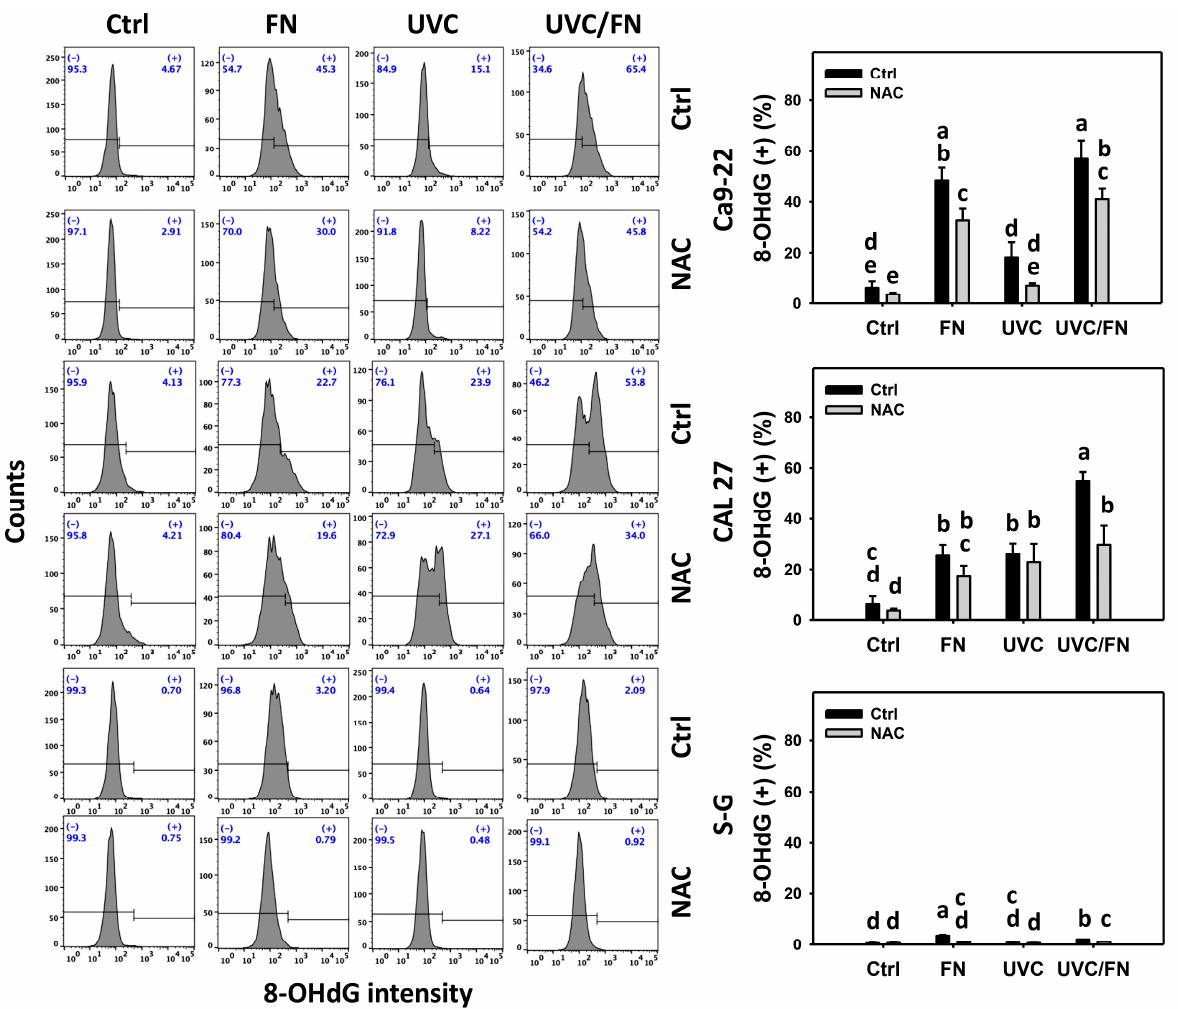
Figure 10. 8-OHdG determination. There are four kinds of treatments for oral cancer (Ca9-22 and CAL 27) and non-malignant oral (S–G) cells: control, FN (300 µ g/mL), UVC (10 J/m 2 for Ca9-22 and S–G; 15 J/m 2 for CAL 27), and UVC/FN (10 J/m 2 for Ca9-22 and S–G; 15 J/m 2 for CAL 27 and 300 µ g/mL for all cell types). NAC indicates that cells were pretreated with 10 mM NAC. Their intensity changes were evaluated by flow cytometry after 24 h treatment. 8-OHdG (+) populations are indicated with (+). Data are given as means ± SD ( n = 3). Lower-case letters determine their significance. Significant differences are indicated by non-overlapping, lower-case letters ( p <